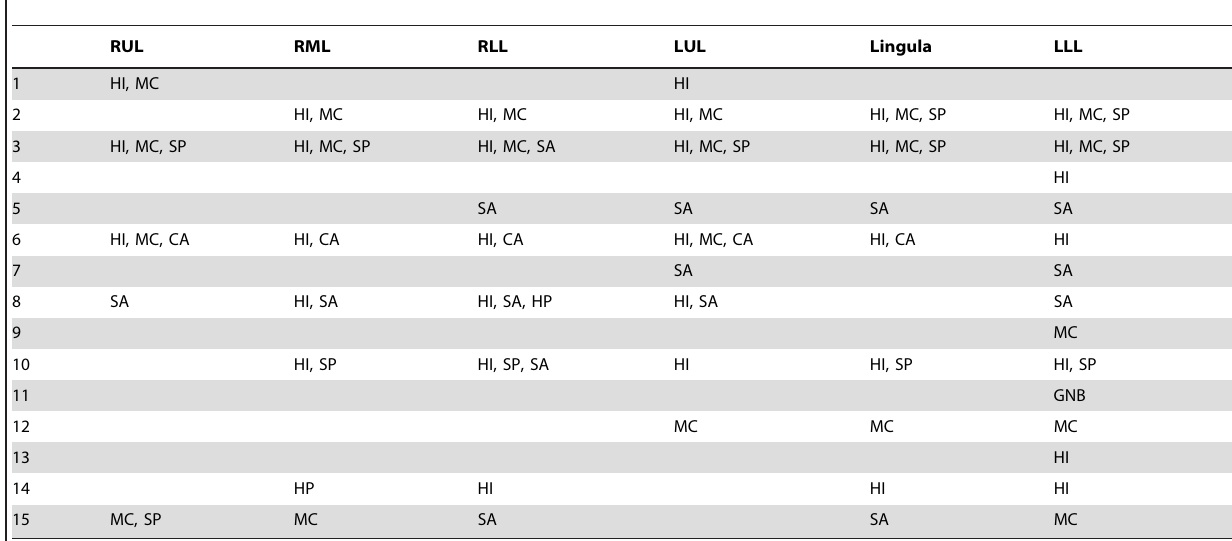
RUL: right upper lobe, RML: right middle lobe, RLL: right lower lobe, LUL: left upper lobe, LLL: left lower lobe, CA: Candida albicans, GNB: Gram-negative bacillus, HI: Haemophilus influenza, HP: Haemophilus parainfluenzae, MC: Moraxella catarrhalis, SA, Staphylococcal aureus ; SP, Streptococcus pneumoniae